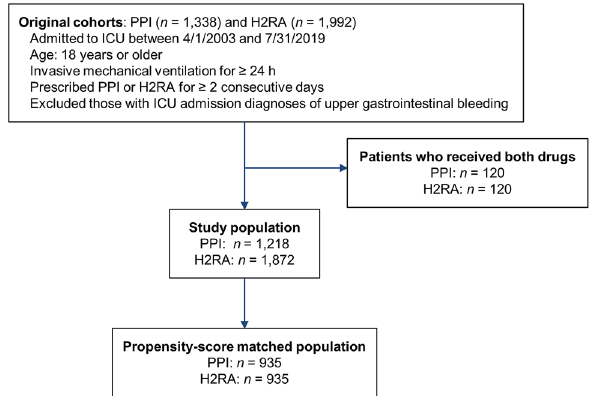
Figure 2. Attrition diagram of the study population. H2RA histamine 2 receptor antagonist, PPI proton pump inhibitor.